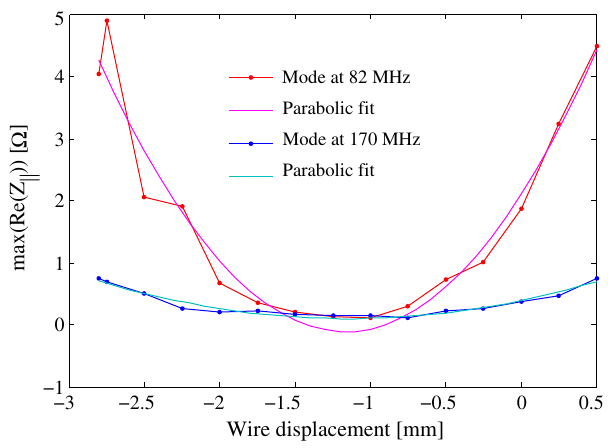
FIG. 14. Longitudinal impedance as a function of the wire displacement with respect to the geometrical center of the collimator aperture. The longitudinal impedance is calculated at the resonant frequency of the resonant modes.